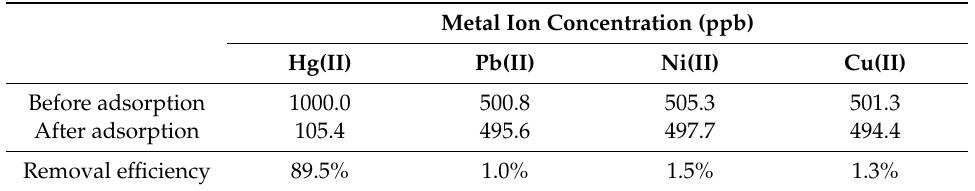
Table 3. Concentrations of Hg(II) Pb(II), Ni(II), and Cu(II) ions in a simulated wastewater before and after treatment with 500Cys-C@Fe 3 O 4 sorbent. The concentrations of each metal ion in the treated wastewater shows the amount of residual metal contaminants after